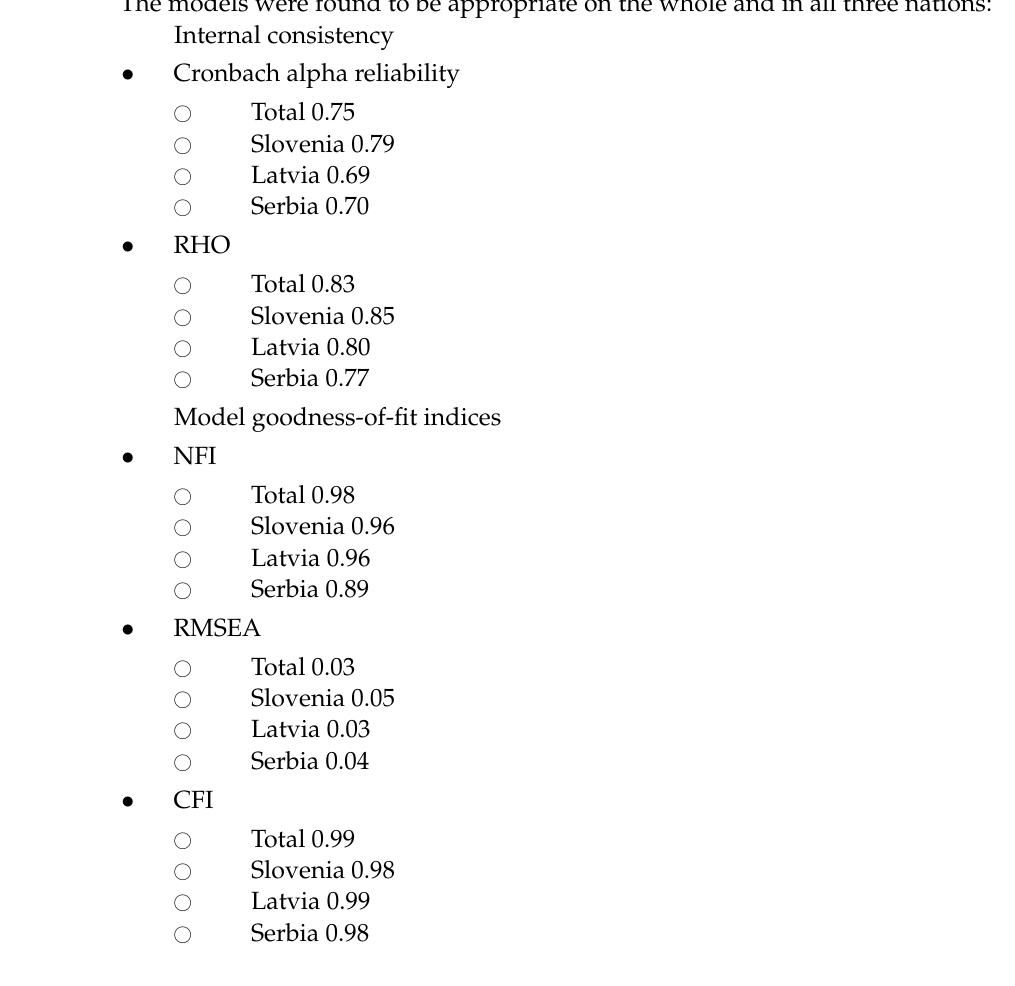
Table 3. Structural equation modeling results (standardized coefficients and variance explained).